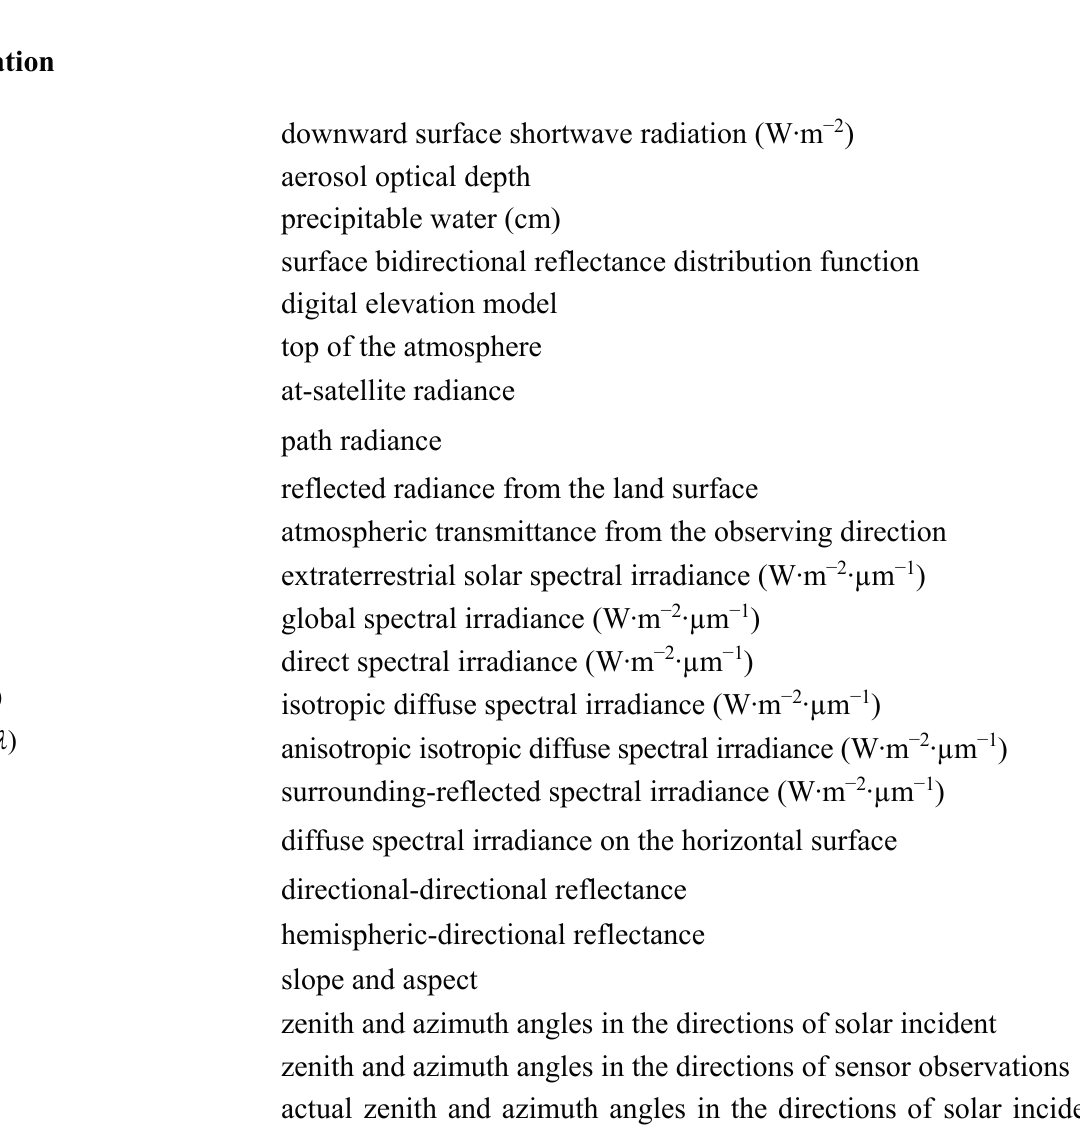
Keywords: topographic correction; Bidirectional Reflectance Distribution Function (BRDF) characteristics; Ambrals algorithm; solar radiation; atmospheric